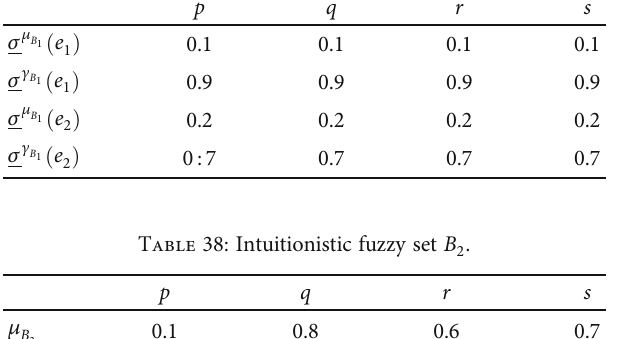
Table 37: Lower approximation of B